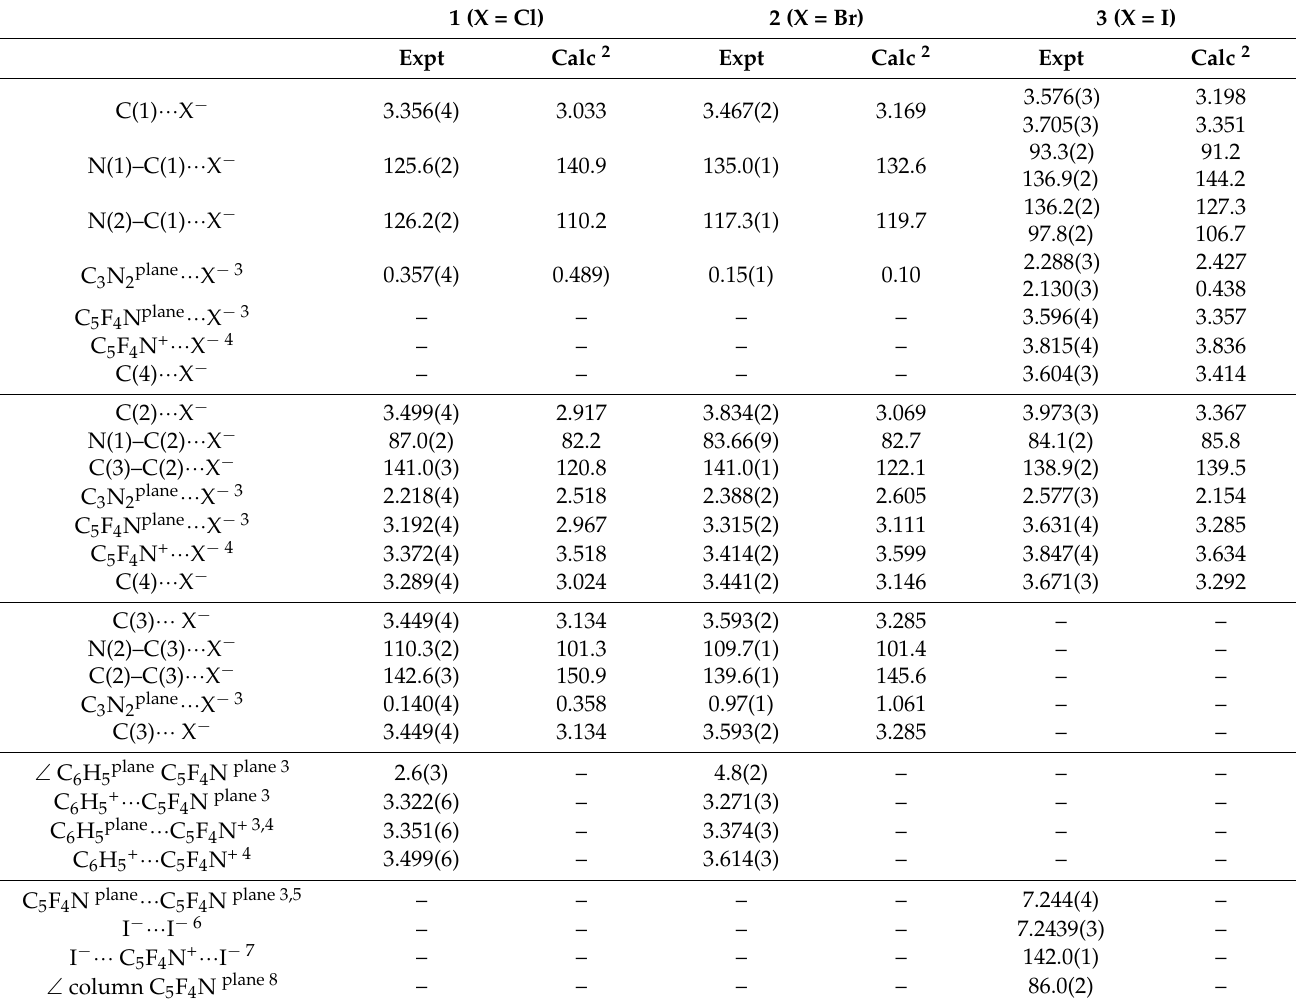
Table 3. This Selected experimental and calculated interionic distances (Å) and angles of ( ◦ )